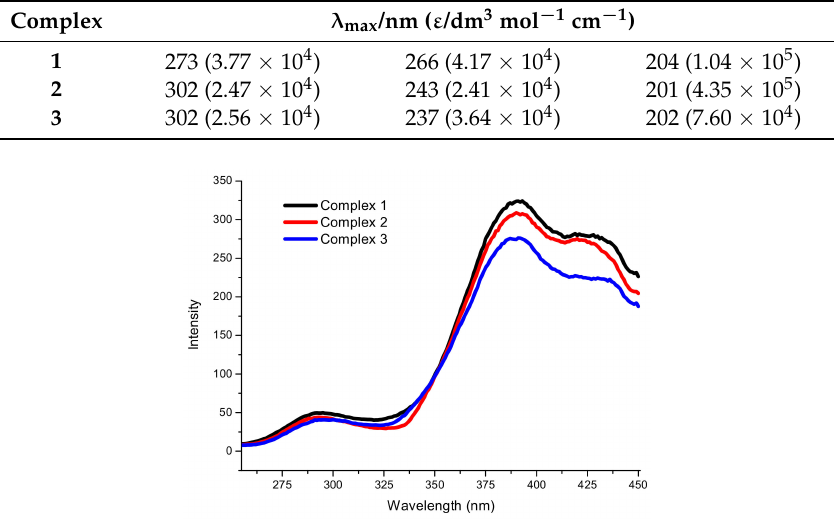
Figure 9. Solid-state emission spectra for complexes 1 – 3